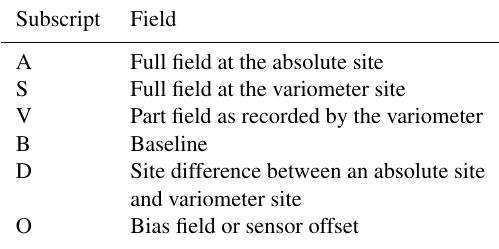
Figure A1. Variation of declination angle at the variometer sensor. The difference between D A (absolute declination) and D B (baseline declination) is the declination variation in the variometer sensor. Table A1. Definition of field